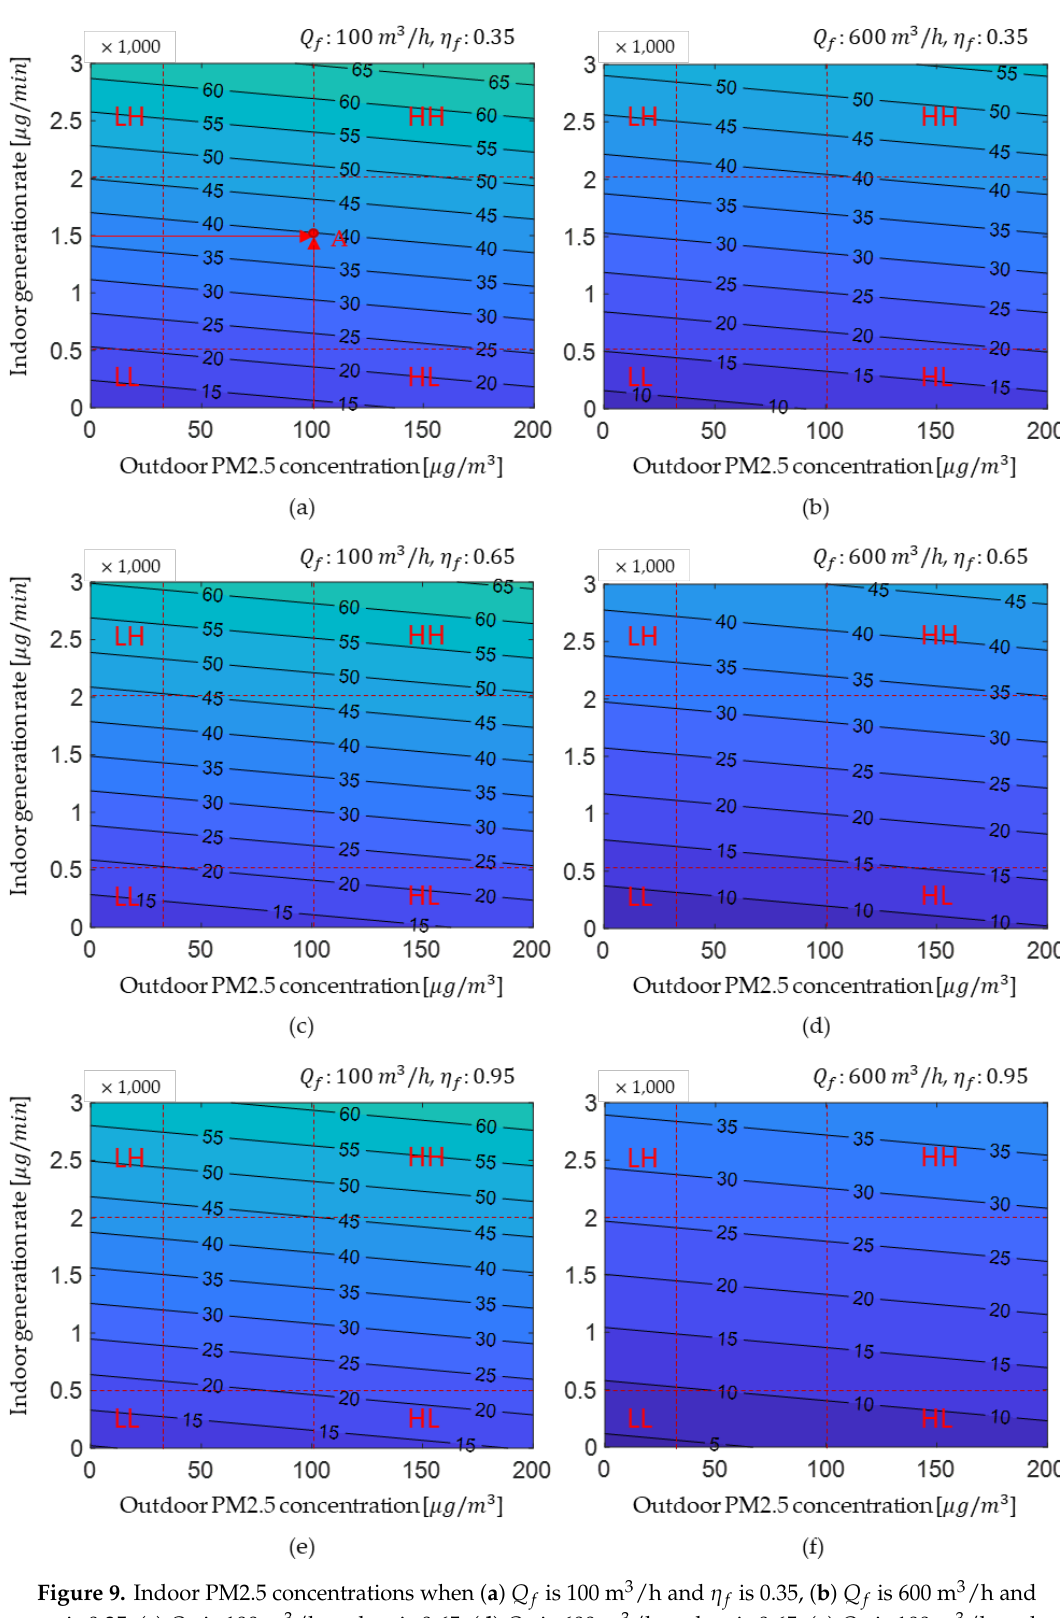
Figure 9. Indoor PM2.5 concentrations when ( a ) 𝑄 𝑓 is 100 m 3 /h and 𝜂 𝑓 is 0.35, ( b ) 𝑄 𝑓 is 600 m 3 /h and 𝜂 𝑓 is 0.35, ( c ) 𝑄 𝑓 is 100 m 3 /h and 𝜂 𝑓 is 0.65, ( d ) 𝑄 𝑓 is 600 m 3 /h and 𝜂 𝑓 is 0.65, ( e ) 𝑄 𝑓 is 100 m 3 /h and 𝜂 𝑓 is 0.95, and ( f ) 𝑄 𝑓 is 600 m 3 /h and 𝜂 𝑓 is 0.95.